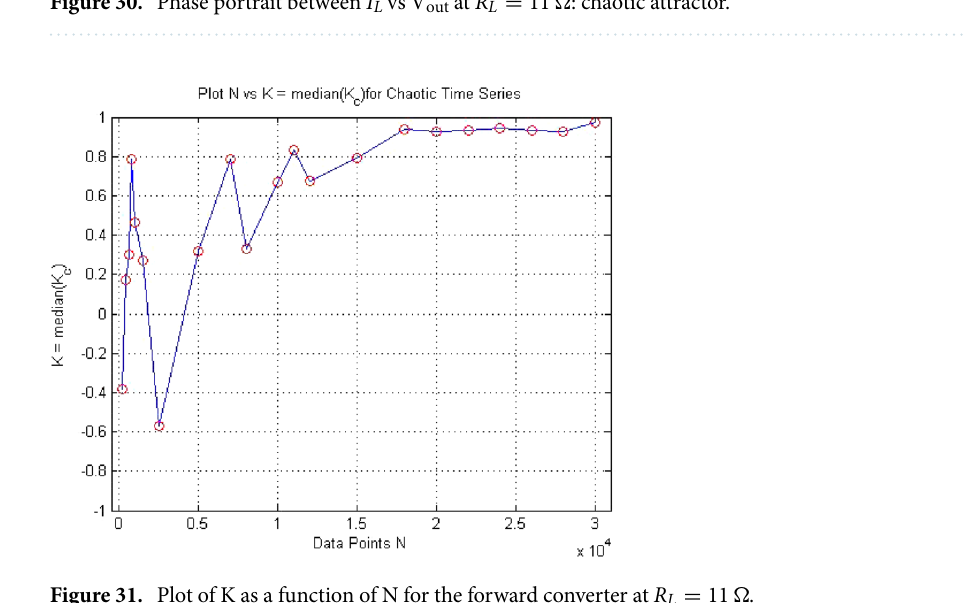
Figure 31. Plot of K as a function of N for the forward converter at R L = 11 (cid:31)